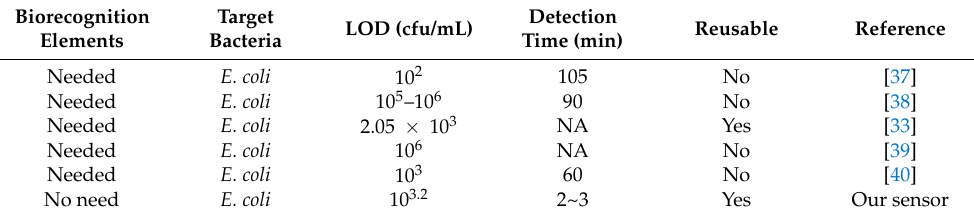
Table 3. Comparison of other sensors developed to detect food pathogens with our ID µ E